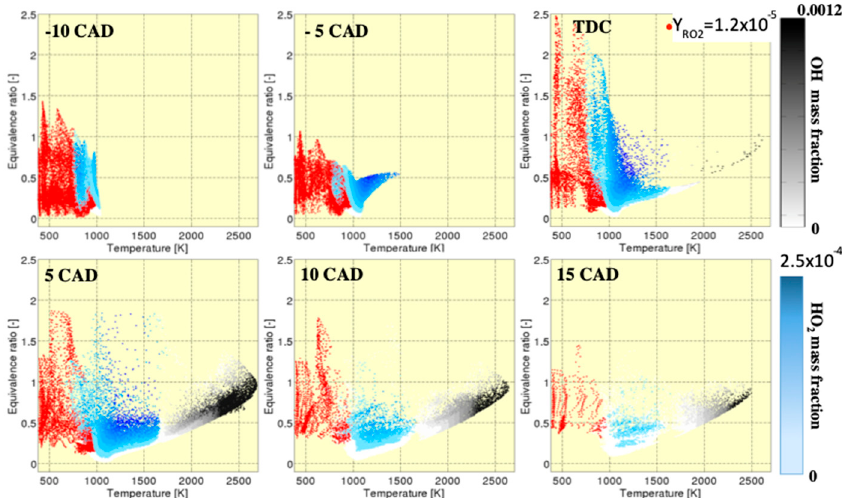
Figure 6. Three species typical for the low, intermediate, and high temperature combustion chemistry regimes plotted in the equivalence ratio and temperature phase space, from − 10 to 15 CAD for the baseline case 1. An active low-temperature chemistry event is indicated by RO 2 until 5 CAD; thereafter, ignition is initiated at higher temperatures. The main-stage heat-release is found to start between top-dead-center (TDC) and 5 CAD and lasts until 10 CAD to 15 CAD.